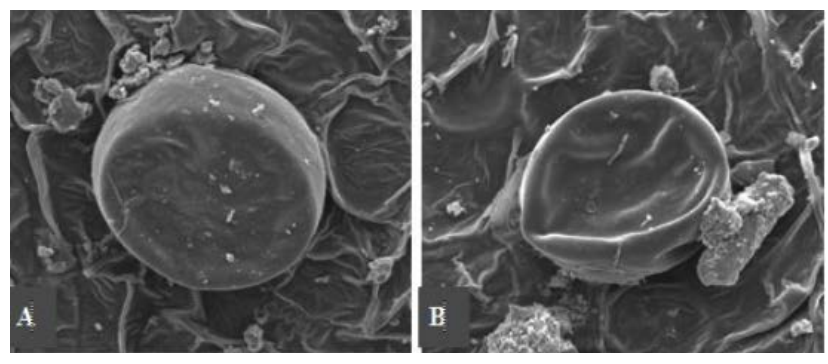
Figure 5. GT cell shape before (A) and after (B) PEF